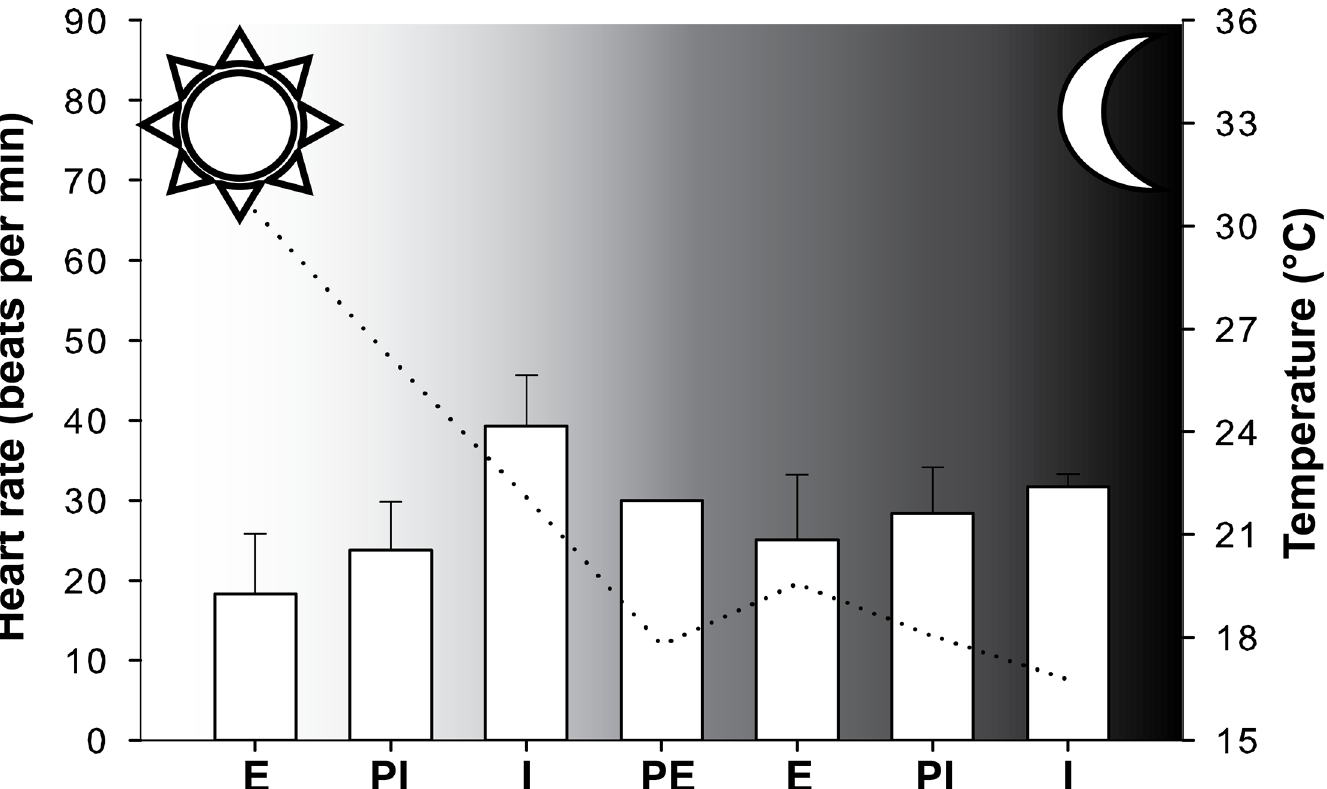
Fig 4. Heart rate variability during a complete tidal cycle measured for P . perna east individuals (average ± standard deviation, n = 2). The dotted line shows the variation in the average temperature measured during the recording. The sun and moon symbols indicate the day and night periods. E, emersion; PE, partially emersed; I, immersion; PI, partially